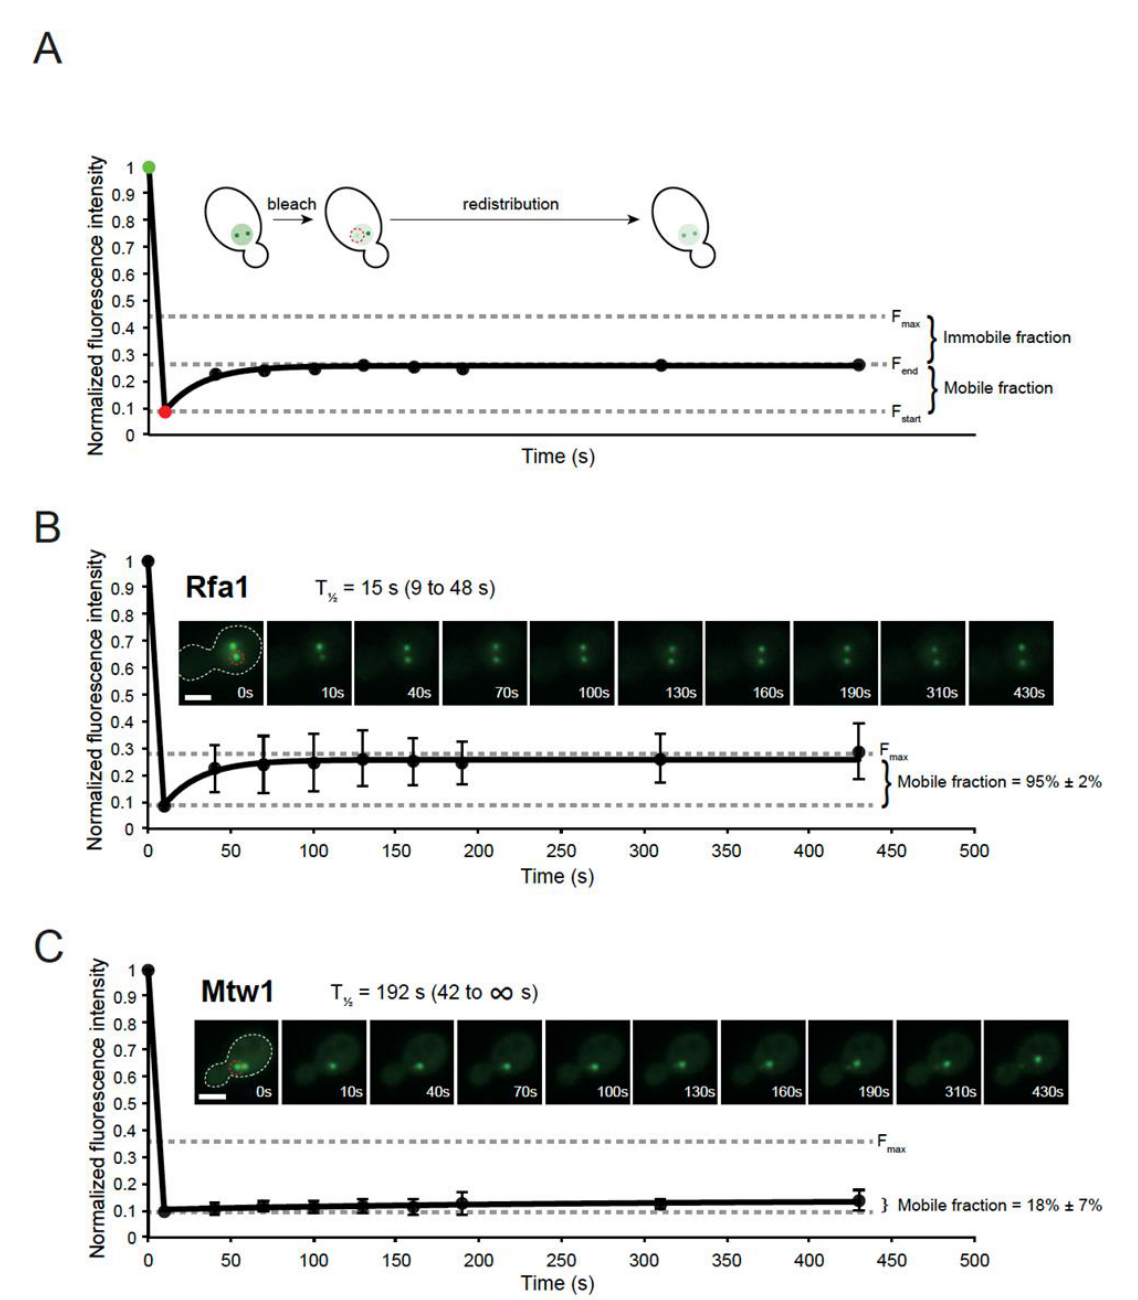
FIGURE 16: iFRAP analysis of Replication protein A and kinetochore subunit Mtw1. (A) Principle of iFRAP method. An image is acquired immediately before (green data point) and after (red data point) laser bleaching of one of two subnuclear foci (indicated by dashed red circle). The fluorescence intensity of the focus before bleaching is set to 1 and all subsequent fluorescence measurements are normalized accordingly. F start indicates the fluorescence intensity of the bleached focus immediately after laser bleaching. F end indicates the plateau fluorescence intensity that the bleached focus approaches during redistribution. F max indicated the maximum fluorescence intensity that the bleached focus can reach at the end of the experiment assuming 100% redistribution. The mobile protein fraction can be calculated as (F end - F start )/(F max - F start ). (B and C) Cells with two foci were subjected to photobleaching of one focus (indicated by dashed red circle) at t = 8s. Fluorescence redistribution was quantified at subsequent time points. The redistribution half-time (T 1/2 ) is indicated with 95% confi- dence intervals in parentheses. Scale bar, 3 µm. The protein mobile fraction is indicated ± standard deviation. (B) RPA dynamically ex- changes at DNA damage-induced foci. Cells expressing Rfa1-YFP (ML306) were grown in the presence of 200 µg/ml Zeocin for 2 hours to induce DNA repair foci. (C) Mtw1 is a stable component of the kinetochore. Cells expressing Mtw1-GFP [368] were arrested in M phase by treatment with 10 µg/ml nocodazole for 2 hours. One-phase association non-linear regression was performed using GraphPad Prism soft- ware. Error bars indicate